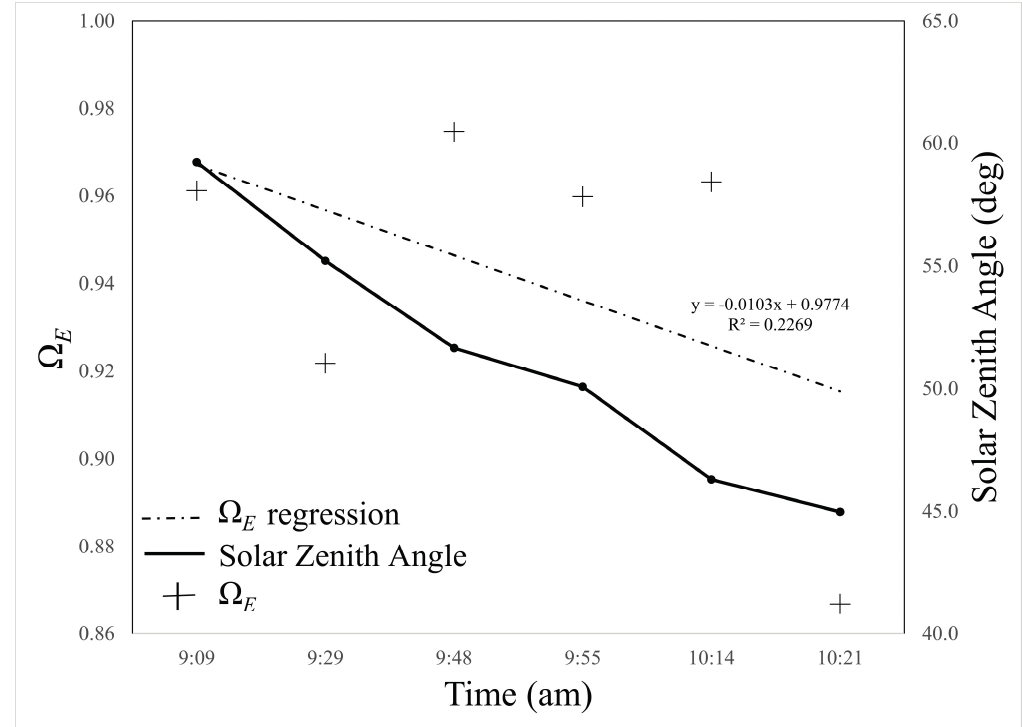
Figure 4. Atmospheric effects on the element clumping index measured by TRAC. Notice the upward trend coinciding with the lowering of humidity after a cold front passed on 5 August 2004.